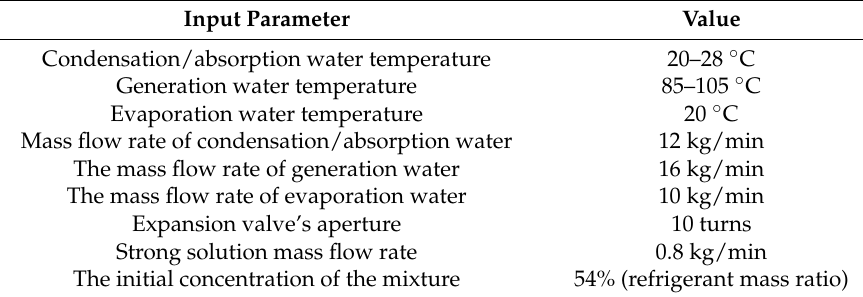
Table 4. Input parameters values during the assessment of the